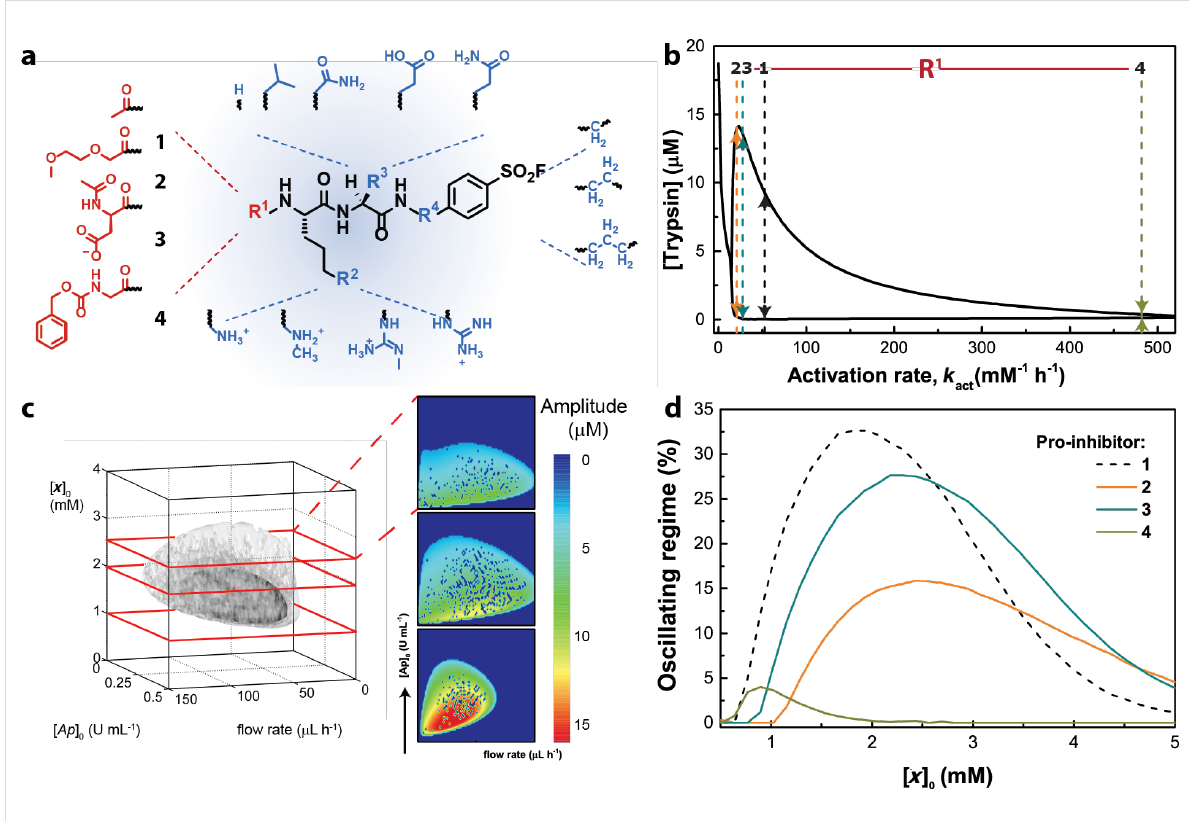
Figure 7: Influence of molecular structure on the properties of CRNs. (a) Molecular “Swiss army knives” showing the opportunities for tunability in dif- ferent enzymatic reaction networks. (b) Bifurcation diagram with the control parameter activation rate of pro-inhibitors that were modified at position R 1 (in red). (c) Phase plot analysis showing regimes of stable steady states are stable limit cycles, with the latter depicted as a grey volume. (d) This was used to predict the performance of the pro-inhibitor under flow conditions. Adapted with permission from [96], copyright 2015 American Chemical